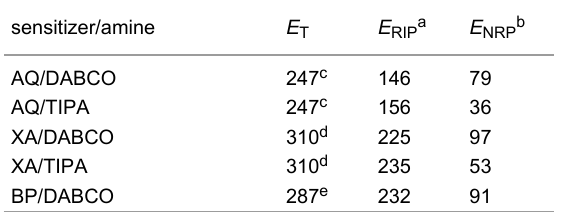
Table 1: Triplet energies E T of the sensitizers, energies of the radical- ion pairs E RIP , and energies of the pairs of neutral radicals E NRP for the sensitizer/amine combinations used in this work. All energies are in kJ/mol and relative to the ground-state energies of the sensitizer plus the